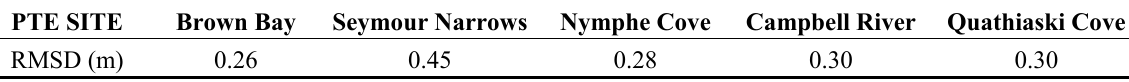
Table 3. Root-mean-square deviation (RMSD) between model derived water levels and the predicted tidal elevations